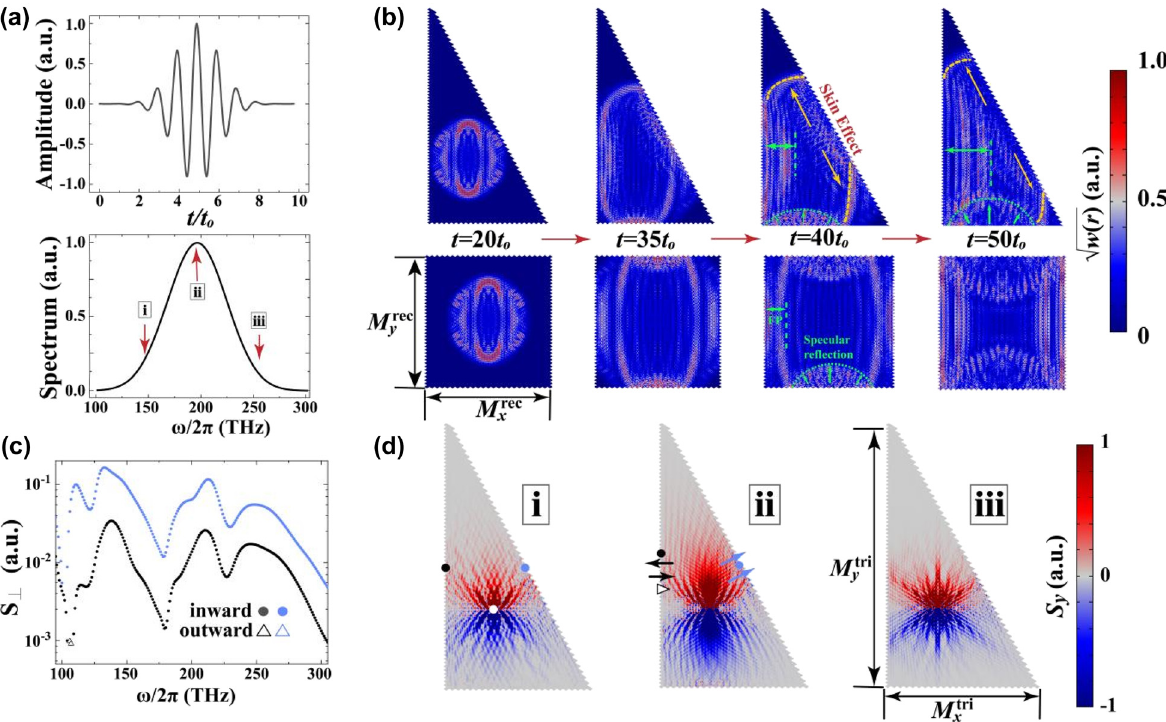
Figure 4: Wave behaviors for the GDSE excited in time and frequency domains. (a) The profile of an input Gaussian pulse in the time domain and its spectrum in the frequency domain. The Gaussian pulse is defined by [ ] 2 } , where f 𝜋 f − 1 ∕ f = 195 THz and f = 40 THz are the central frequency and standard deviation, J z = cos (2 𝜋 f 0 ( t − 1 ∕ f 1 )) × exp {− 0 ( t 1 ) 0 1 = 1 ∕ f = 5.1 fs. (b) The calculated time evolution of the Gaussian pulse excited inside a respectively. The time step used in this figure is t 0 0 triangle and a rectangle. The color bar is set to square root of the energy density. The dashed green and orange lines, respectively, sketch out the specular reflection and the skin effects. (c) The power flux S ⊥ at the blue and black dots marked in (d) as a function of frequency is highlighted in blue and black. The filled circles (hollow triangles) denote that the averaged power flux is into (away from) the interface. (d) for three frequencies labeled as (i–iii) in the bottom panel of (a). The parameters are 𝛾 = 0.1, M tri The patterns of S y = 25, and M rec = M rec x y